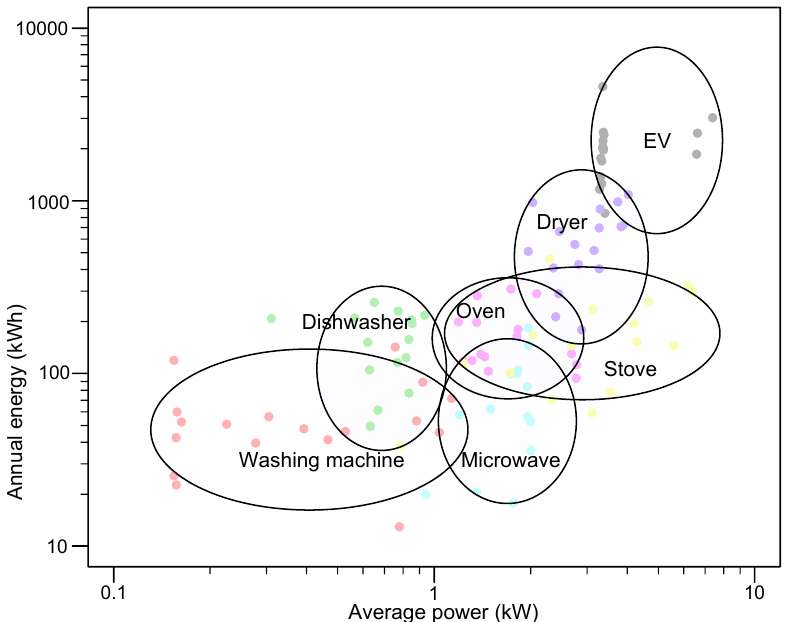
Figure 1. Annual energy (in kWh on y -axis) and average power (in kW on x -axis) of typical appliances of an US household. Source: Pecan Street